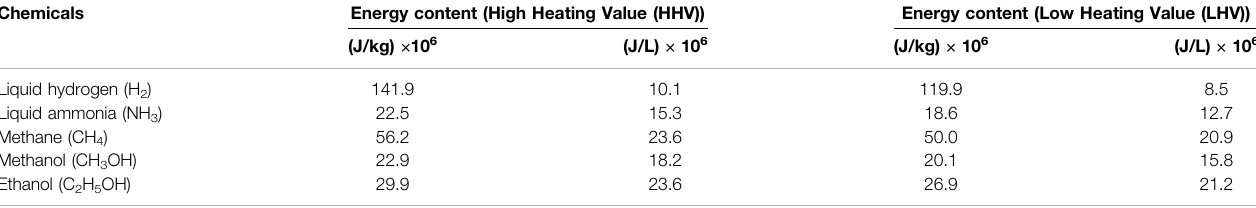
TABLE 1 | Energy content of various fuels in liquid state (Giddey et al., 2013).